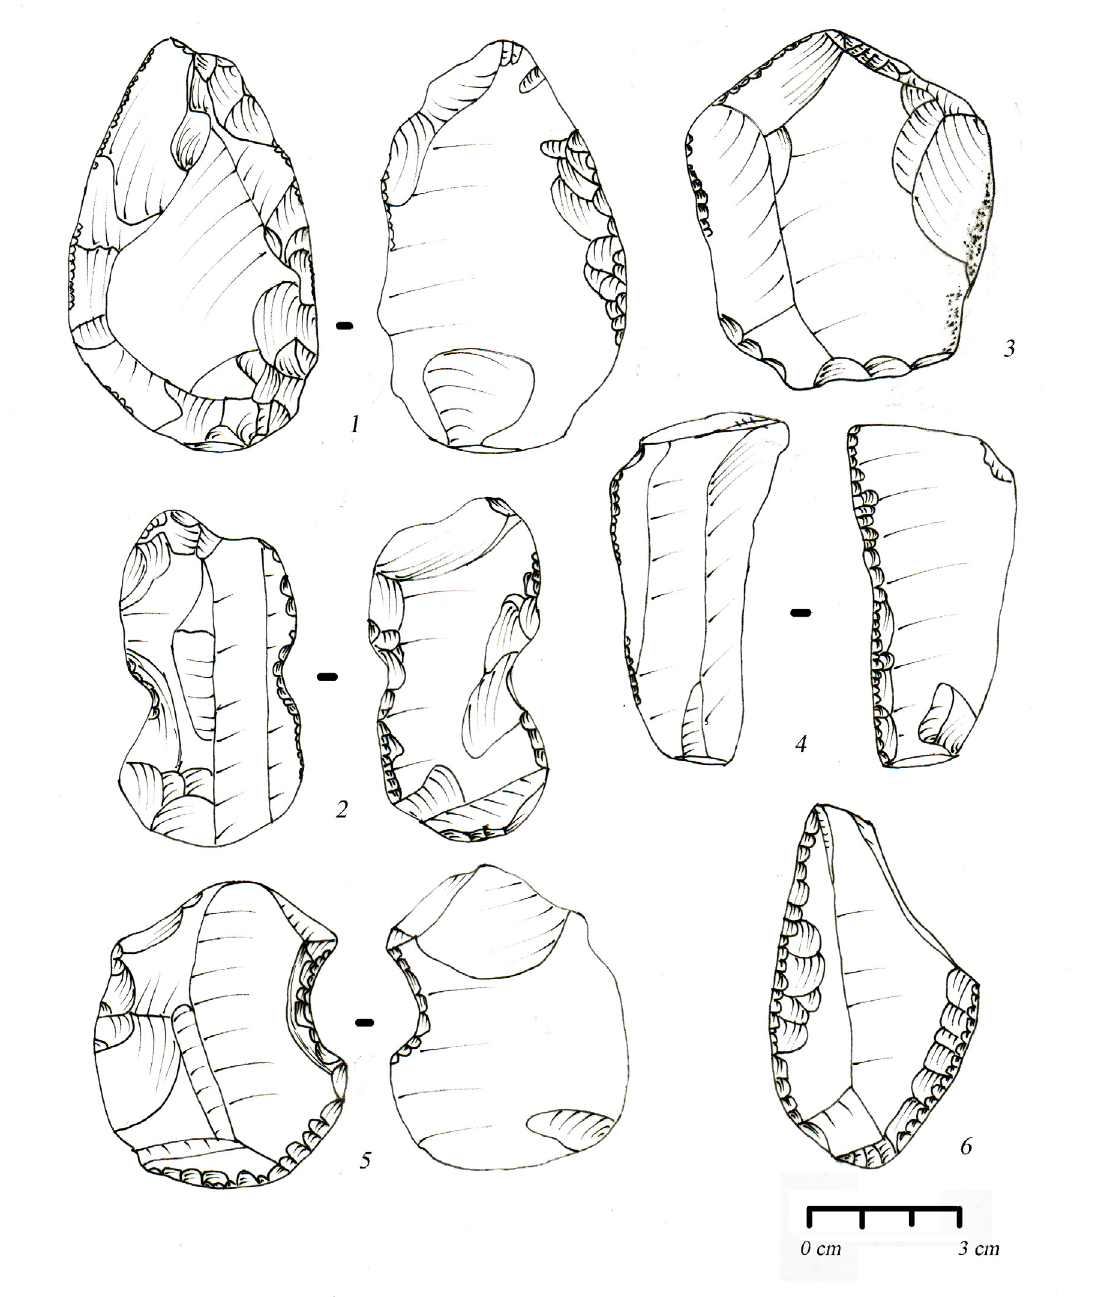
Figure 10. Scraper with flat retouche (1), axe Campignano technique (2), flake scrapers (3, 5–6), Blade scraper (4) (drawings M.C.